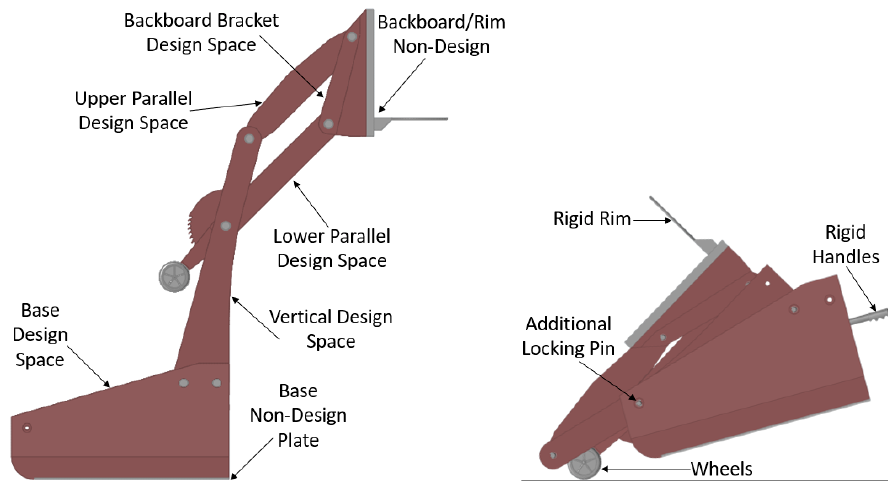
Figure 2. Portable basketball hoop system design spaces and folded